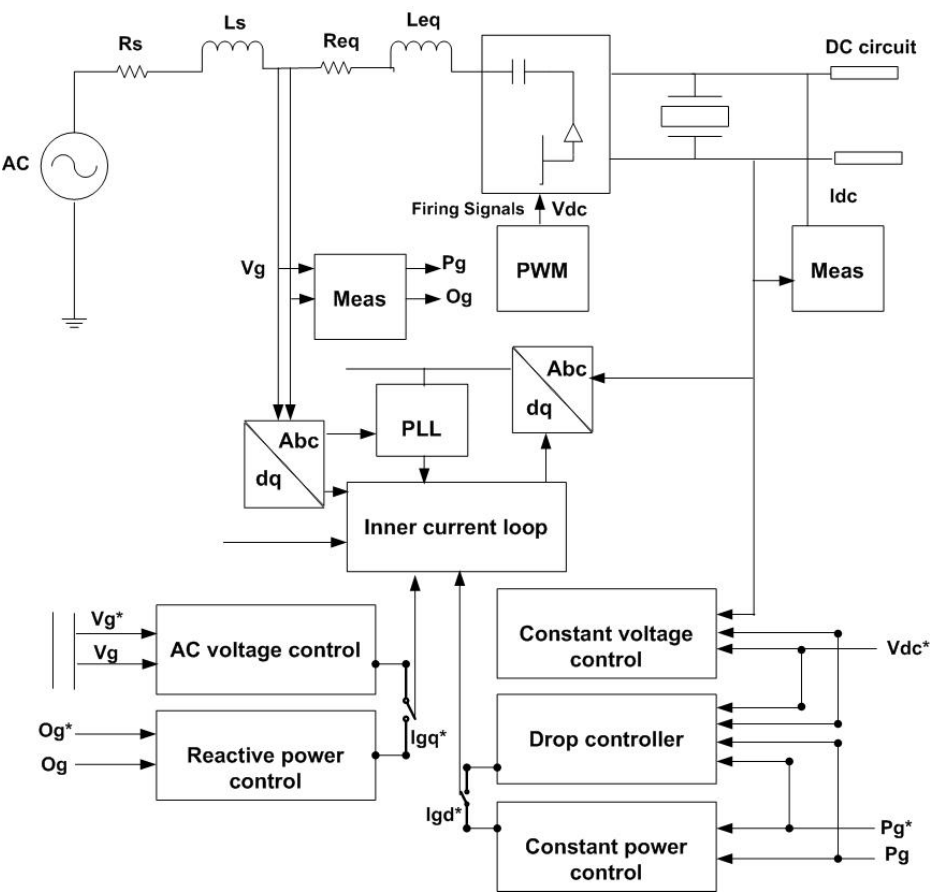
Figure 1. Detailed diagram of the inner current loop controller.